Question: In one sentence, what is this figure communicating?
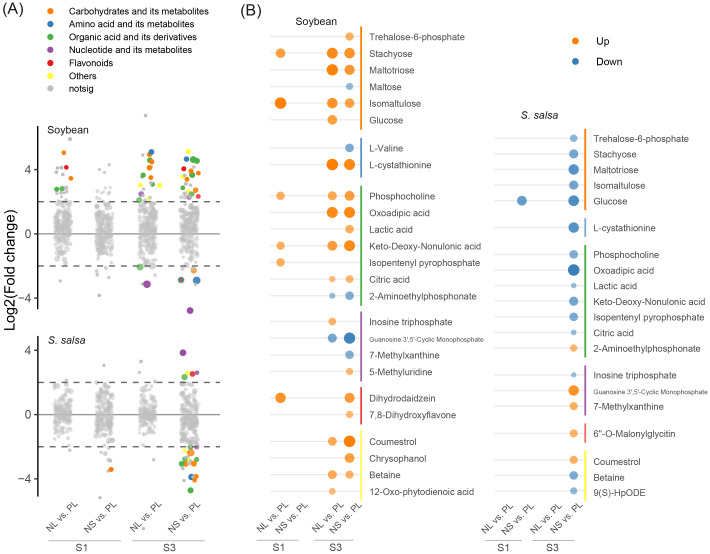
Answer: Rhizosphere differential metabolites of different comparisons. (A) Volcano plot of metabolites; (B) Differential metabolite profiles. Point size in (A) represents –log 2 (p -value); in (B) represents |log 2 (fold change)|. PL, plastic barrier separation; NL, nylon mesh separation; NS, no separation.